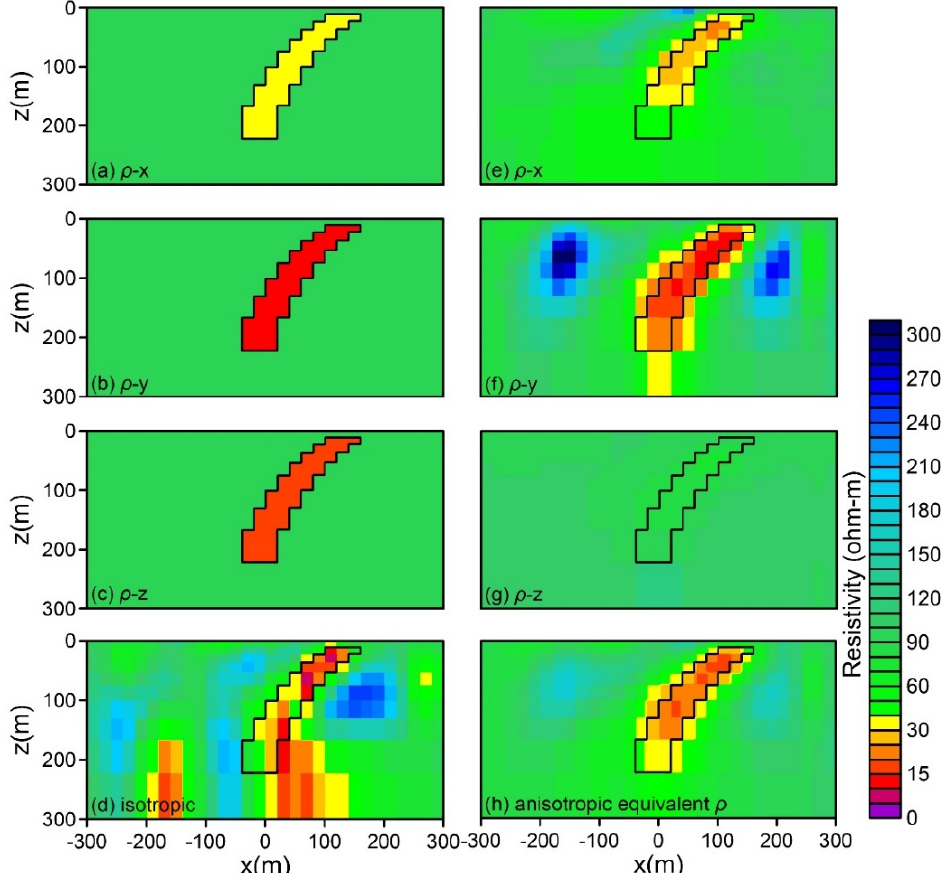
Figure 4. Anisotropic and isotropic inversions for a model with a triaxial anisotropic ore-body embedded in an isotropic half-space. ( a – c ) show the model in x , y, and z -directions; ( d ) shows the isotropic inversion result; ( e – g ) show the anisotropic inversions for resistivities in x , y, and z -directions; ( h ) shows the equivalient resistivity ρ h calculated via Equation (17) from the anisotropic inversion results (all slices are displayed at y = 40m) .